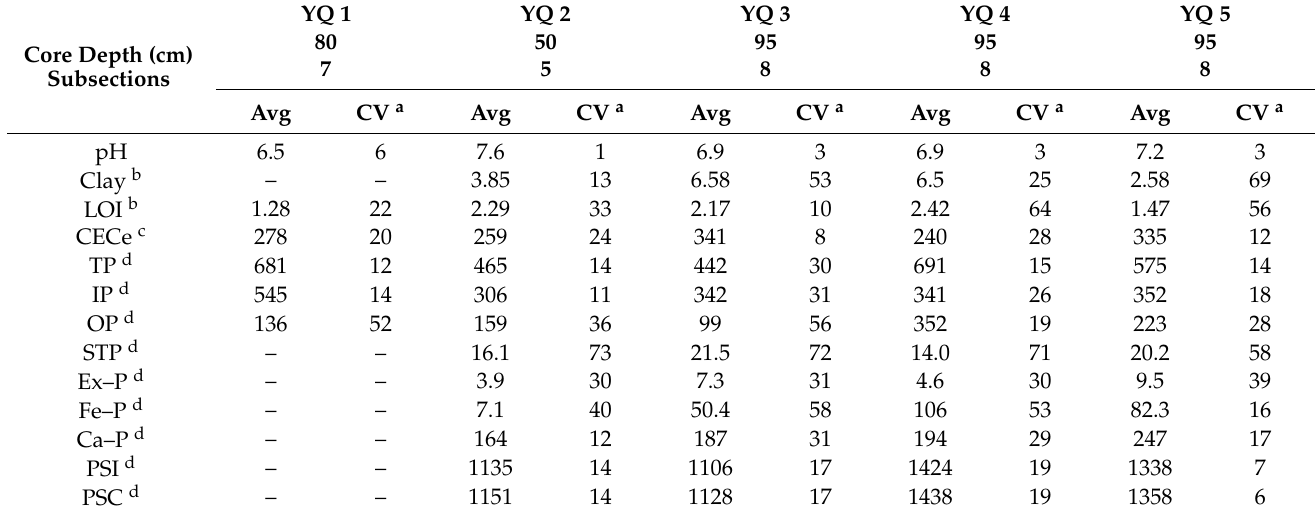
Table 1. Characteristics of five sediment cores in YuQiao